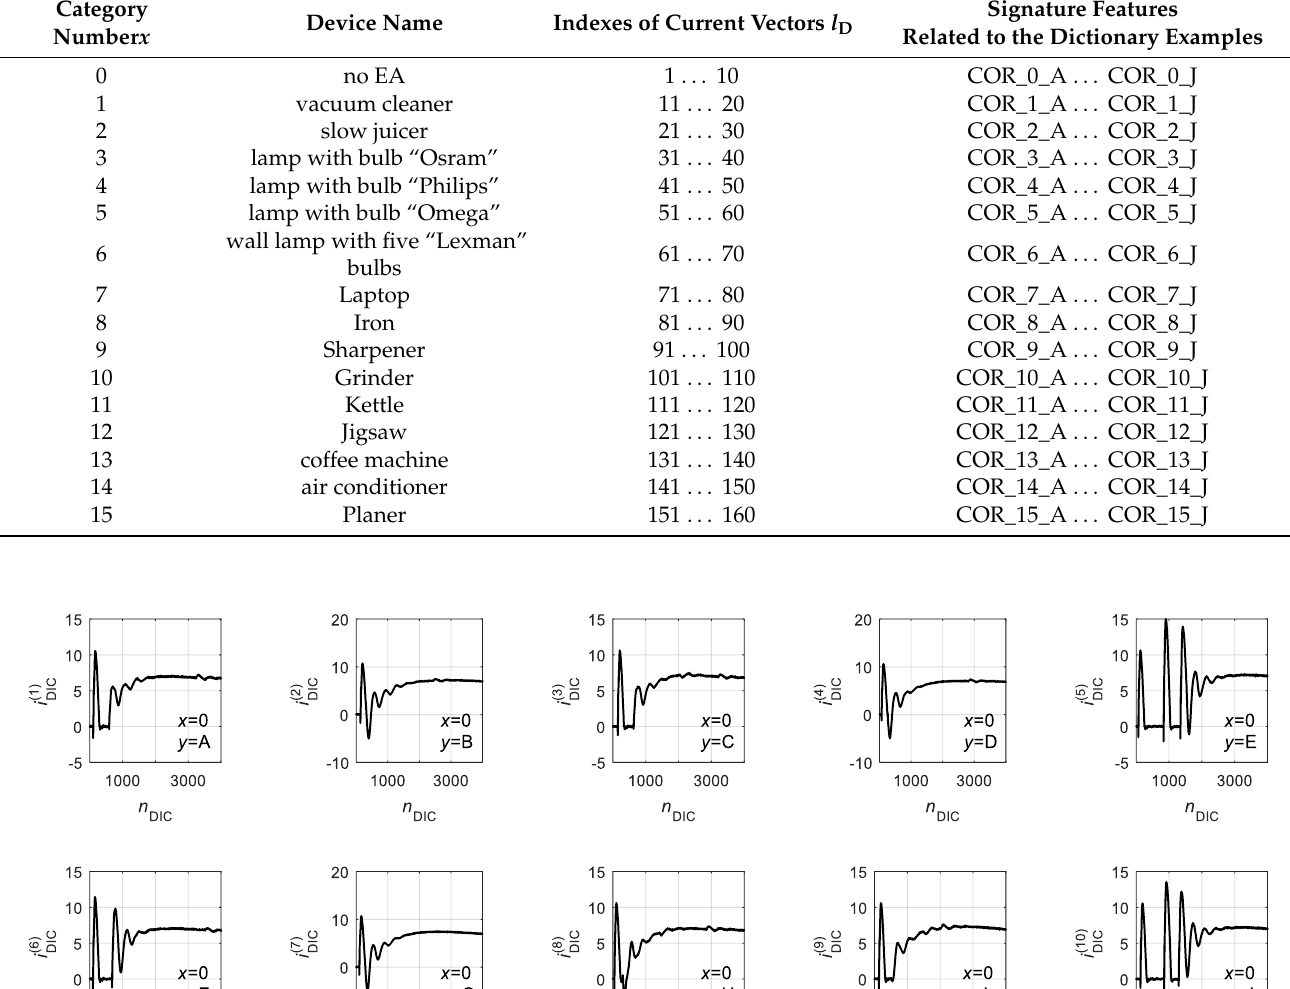
lower than in the no EA case (category 0 in Figure 20). Duration of the oscillation between 1000 n and = 4000 n is the same for all vectors in this category with pe- samples = DIC D I C riod of about 940 samples, which corresponds to a frequency of 31.9 kHz. i DIC for dictionary elements for the category no EA ( x = 0 ) . i for dictionary elements for the category no EA = ( 0 ) x . Figure 20. Current vectors Figure 20. Current vectors DIC